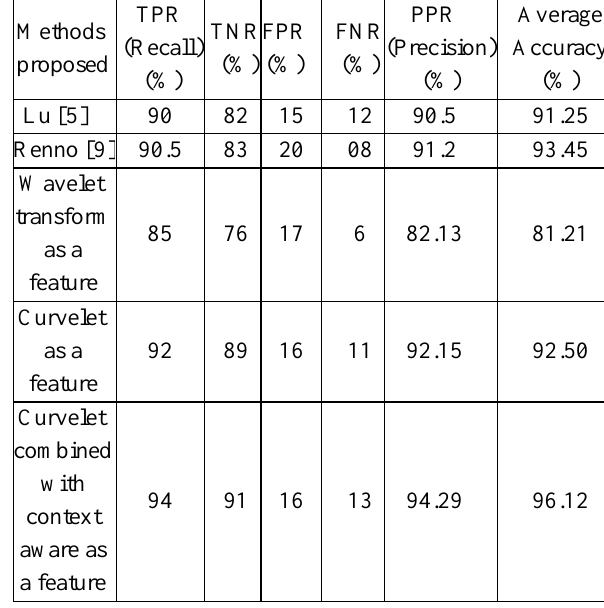
Table 3: Values of Performance Measures of the other state-of-the-art